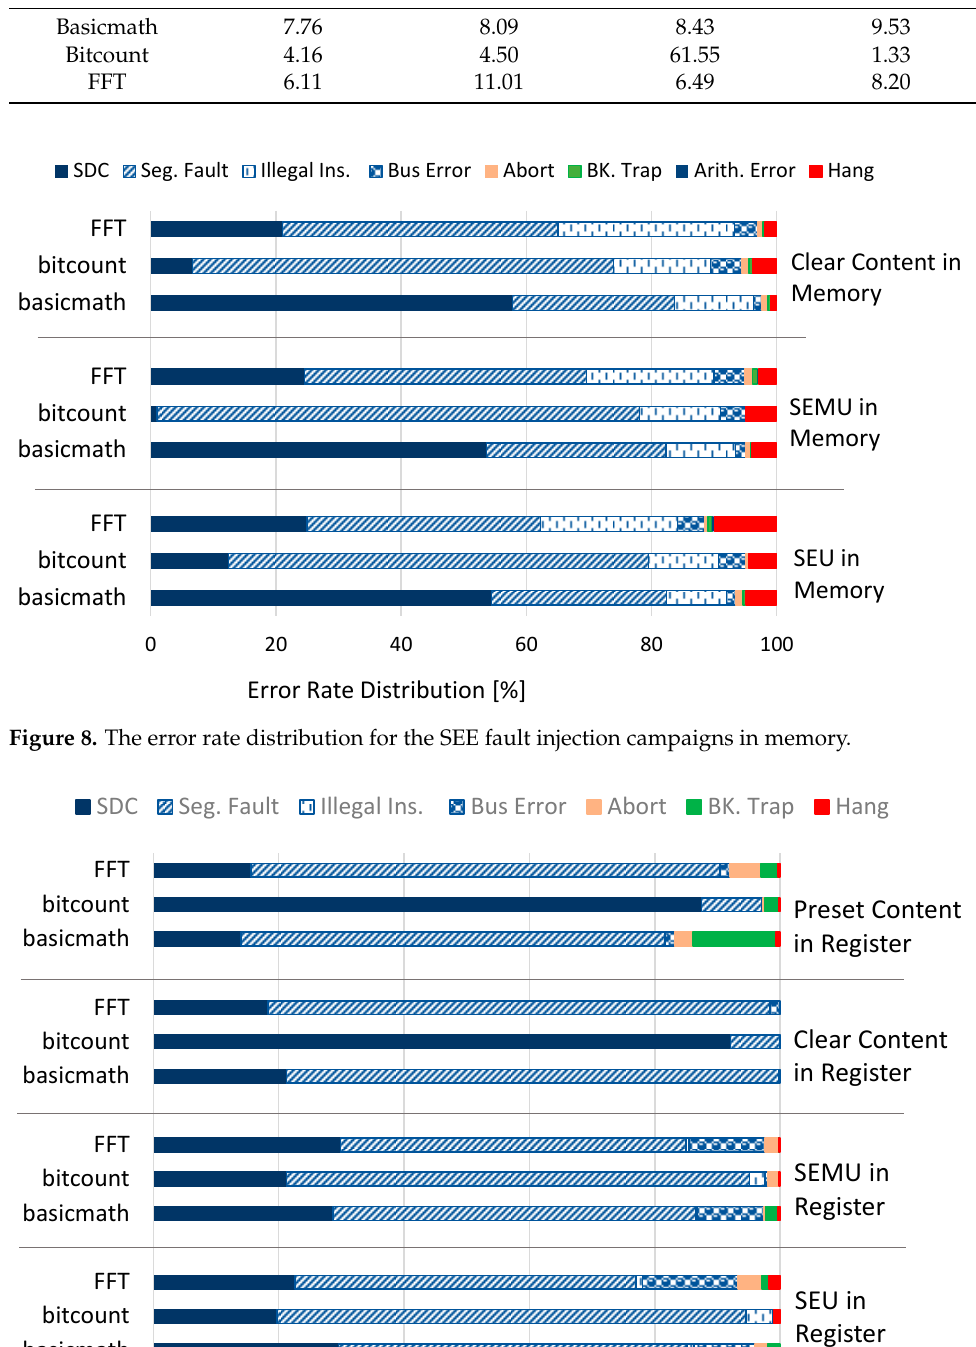
Table 2. Error rate classified per application and fault model in register.